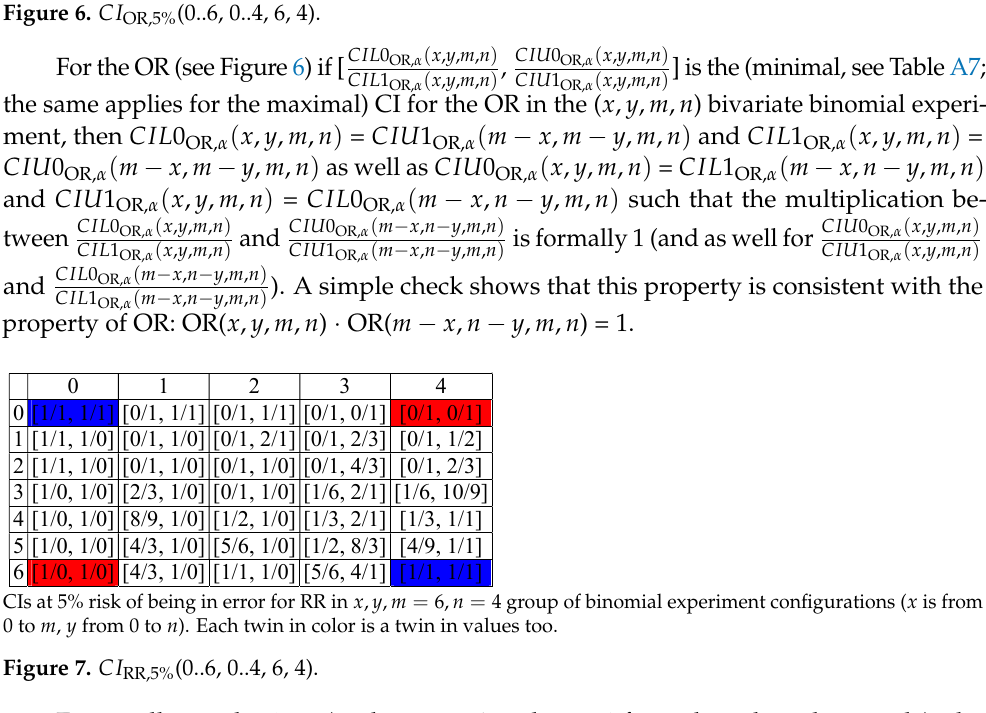
For small sample sizes (such as n = 4 and m = 6 from the selected example), the